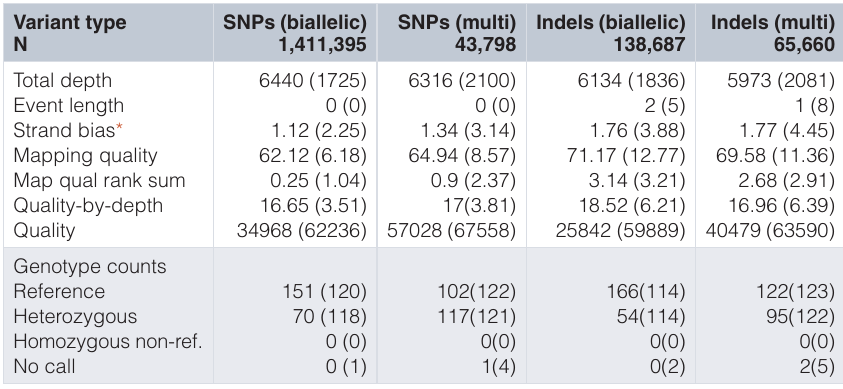
3 for multi-allelic indels (see Figure 4A). Mean separation between